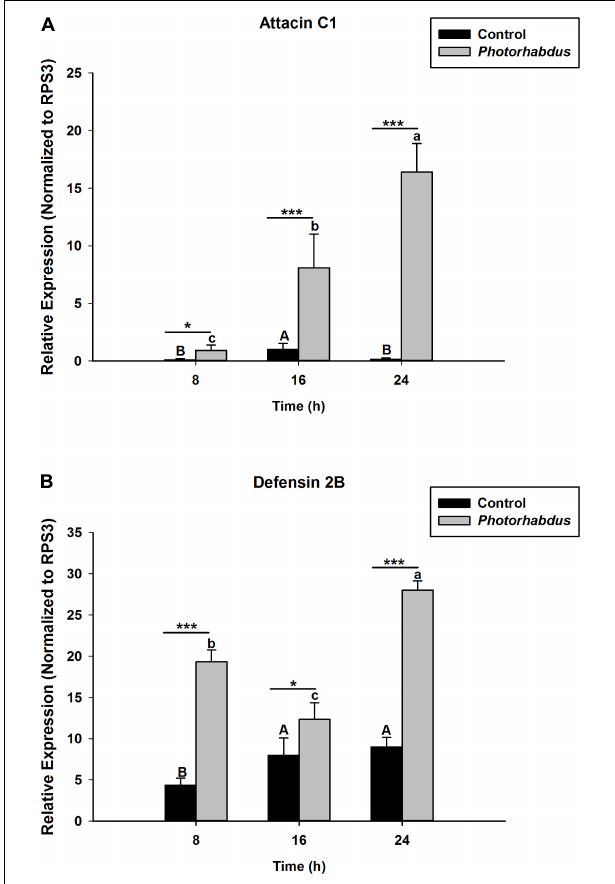
FIGURE 4 | Transcription of antimicrobial peptide (AMP) genes in O. nipae larvae injected with P . luminescens AMP transcription levels were shown for (A) Attacin C1, (B) Defensin 2B. Error bars labeled with different letters are significantly different (one-way ANOVA followed by LSD test, p < 0.05). ∗∗∗ P < 0.0001; ∗∗ P < 0.001; ∗ P < 0.01 indicates significantly different levels between the control and P . luminescens treatments at the indicated time period; while “ns” indicates no significant difference.